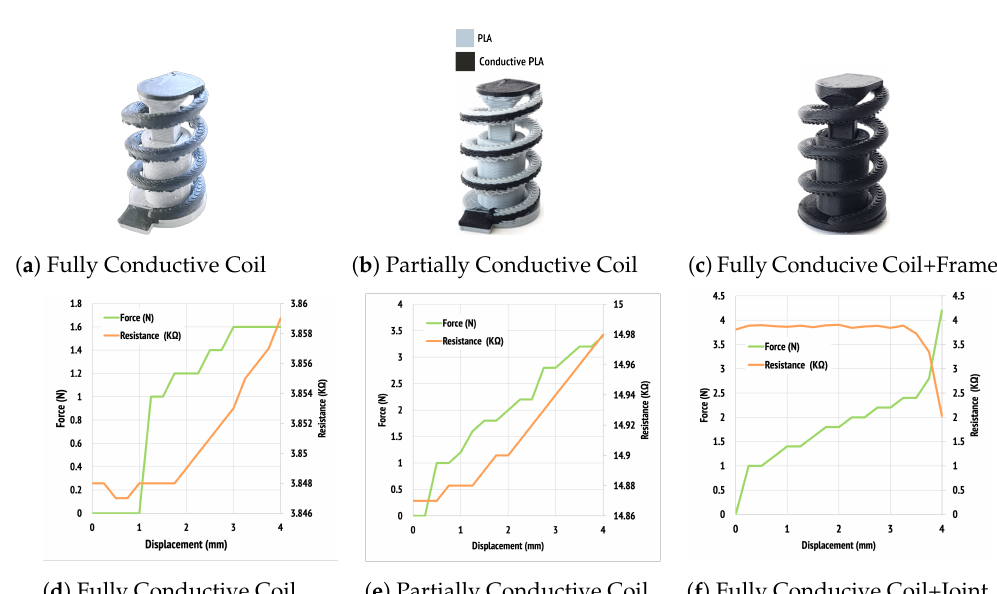
Figure 4. Variation of force-sensing coil spring design: ( a ) Conductive coil with non-conductive prismatic joint, ( b ) Partially conductive coil with non-conductive prismatic joint, and ( c ) Conductive coil with conductive prismatic joint. The force-displacement-resistance changes of each spring design: the result of ( a – c ) are ( d – f ),